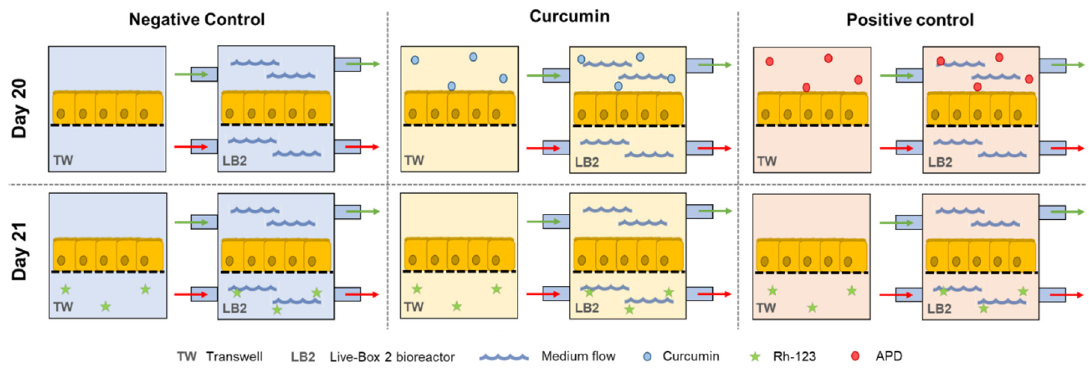
Figure 3. Schematic representation of the six different sample groups for the study of P-gp